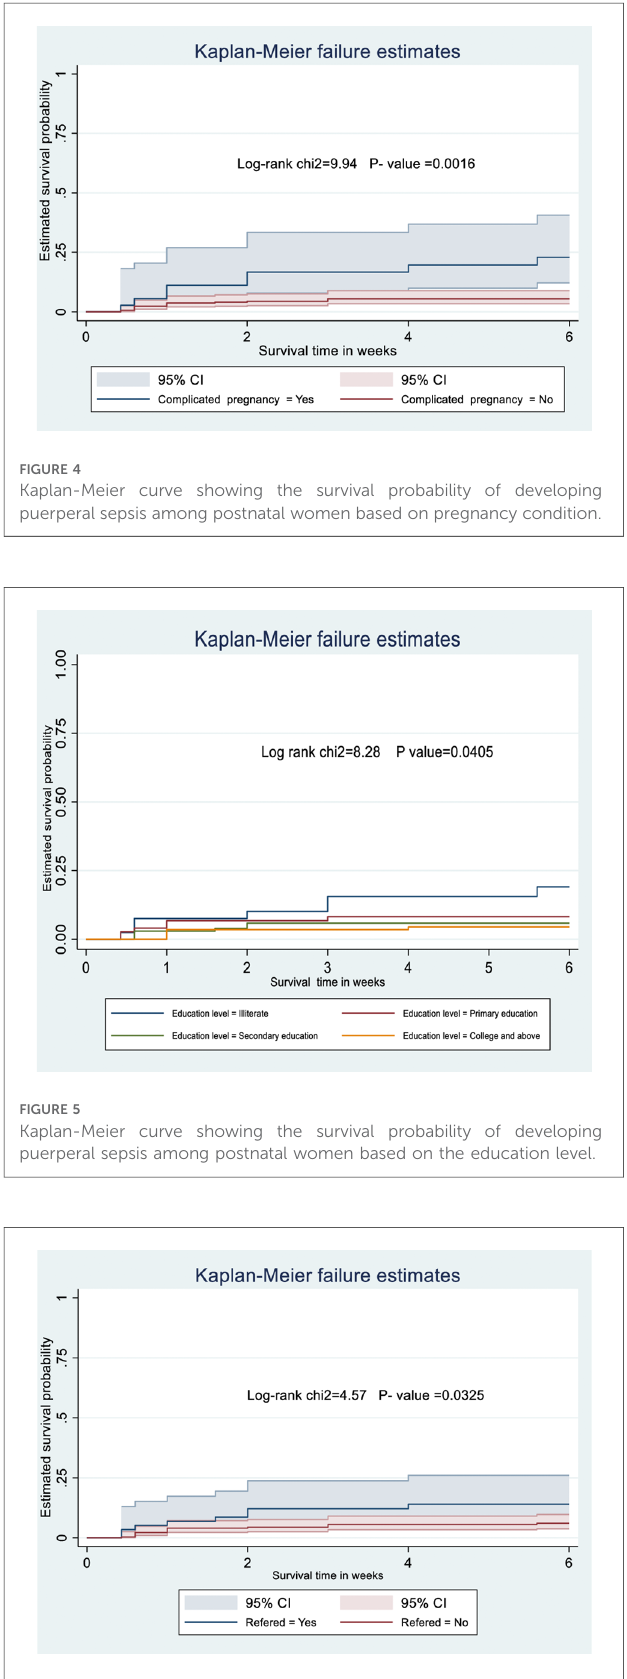
FIGURE 6 Kaplan-Meier curve showing the survival probability of developing puerperal sepsis among postnatal women based on referral